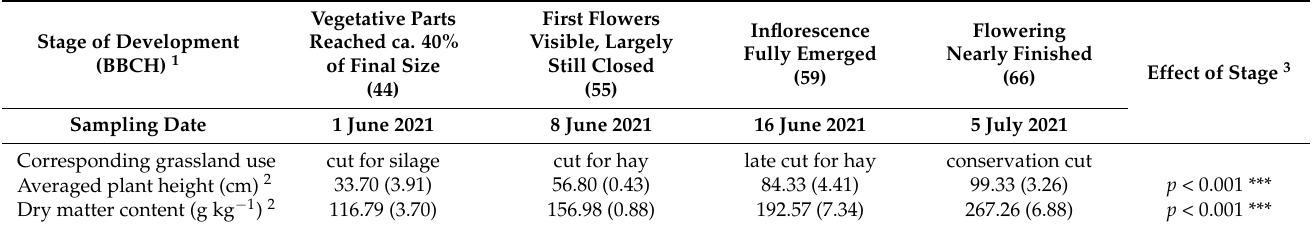
Table 2. Ontogenetic characterization of the developmental stages of J. vulgaris at different cuttings during the